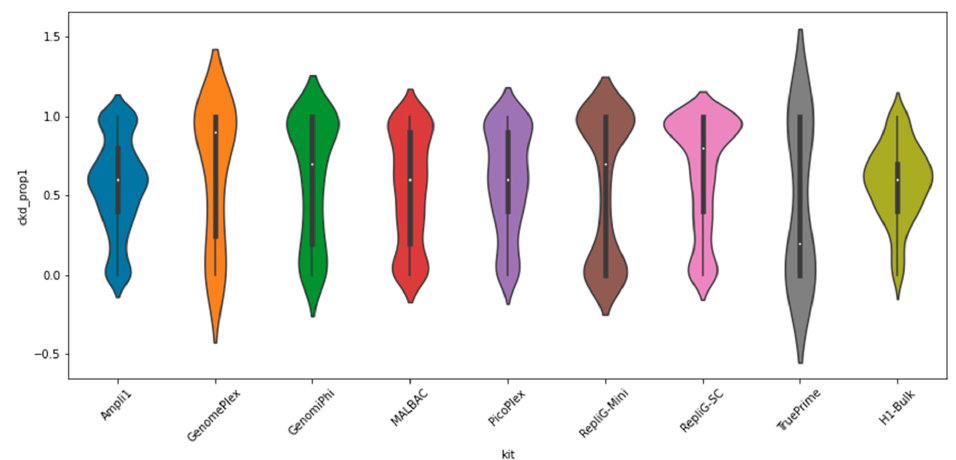
Figure 3. Allelic balance (closer to 0.5 is better)—distribution of proportions between alleles at heterozygous loci, where 0.5 indicates a perfectly balanced result, while 0/1 indicates the worst case. See also Supplementary Material Figures S5 for an alternative view. Ampli1 is notably the most balanced hit, followed by MALBAC and PicoPlex, all of which are PCR-based kits. While the H1-Bulk control depicts the most balanced profile,